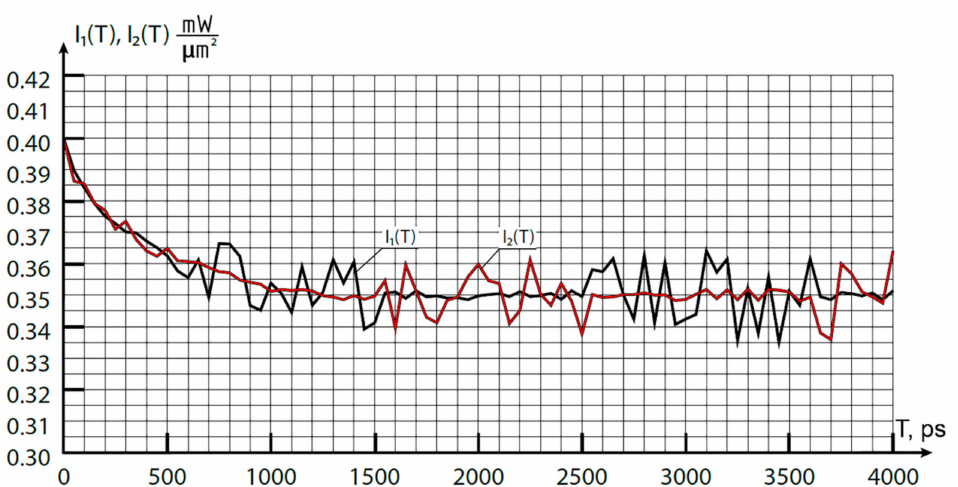
Figure 2. The temporal dependence of the change in the intensities of lasers with resonators intercon- nected through reflected radiation: 1— I 1 ( T ); 2— I 2 ( T